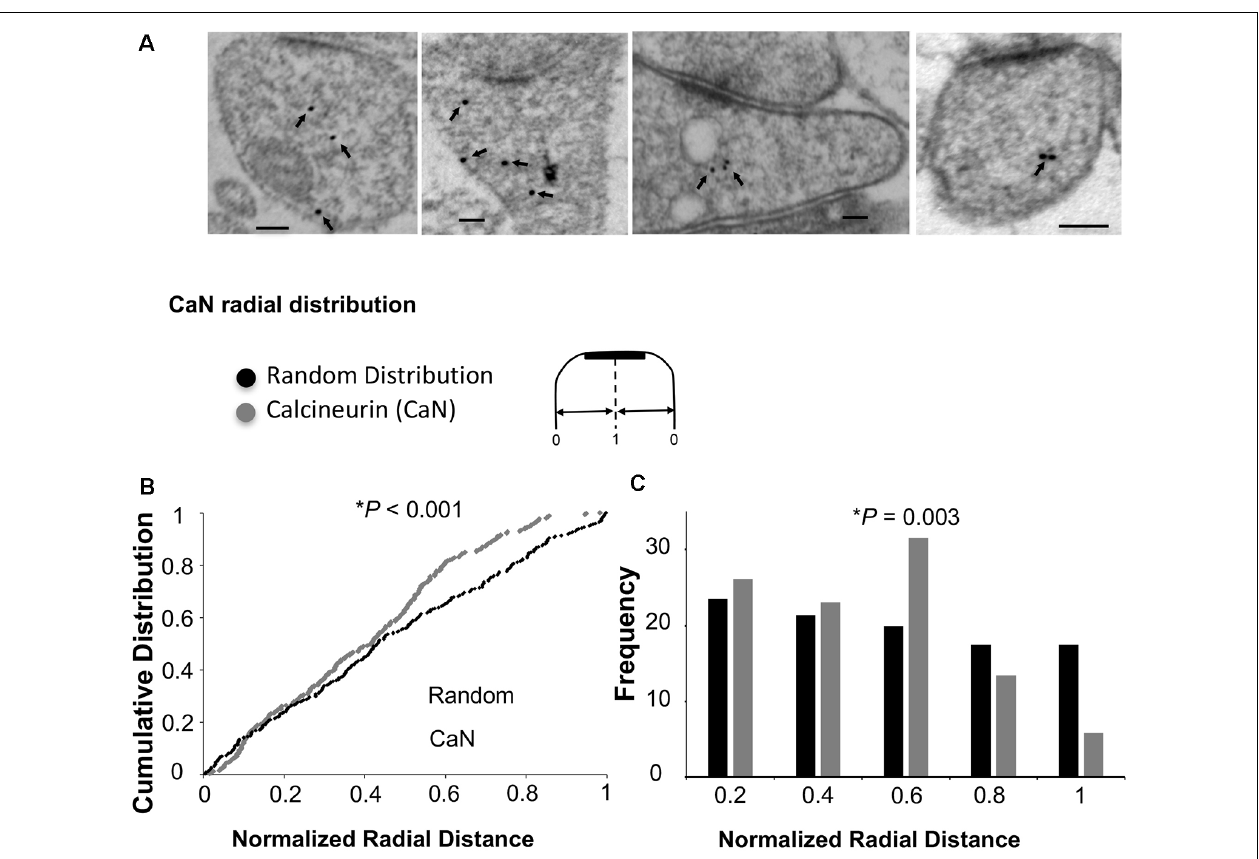
FIGURE 4 | Ultrastructural localization of calcineurin. (A) Representative micrographs of immunogold-EM for calcineurin (CaN). (B) Cumulative probabilities of normalized radial distance. Normalized radial distribution was measured in the same way as described in Figure 3 . The distribution of calcineurin within the spine ( n = 291) is significantly different from a theoretical random distribution (Kolmogorov–Smirnov test, p < 0.001). (C) Frequency histogram for the data presented in (B) also showing that calcineurin distribution is significantly different from a theoretical random distribution using Chi-square. Interestingly, the highest fraction of labeling for calcineurin is not close to the plasma membrane but rather closer to the center of the spine (0.6 of the radial distance).